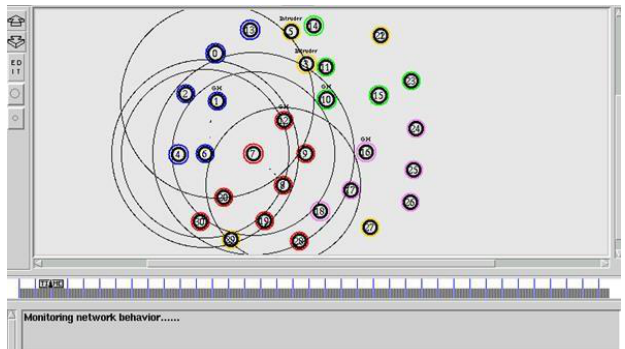
Figure 3 . Cloud service providers and consumers